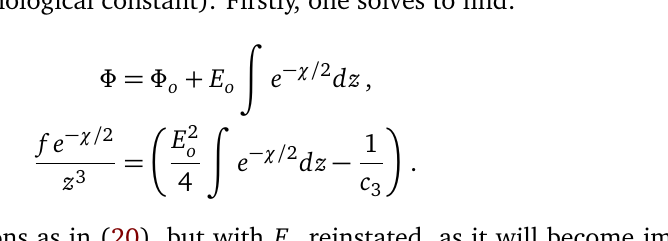
Figure 6: Evolution of z φ (cid:48) and − zg (cid:48) = 0.962 (solid), 0.934 (dashed), 0.899 (dotted) and 0.858 (dot-dashed). There T / T c of the metric becomes less dramatic. Numerics are with m 2 = − 2 and q =